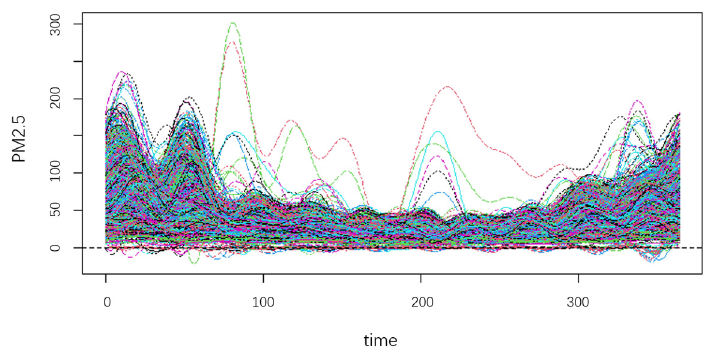
Figure 4. The PM 2.5 concentrations at all sites (one color stands for one station).